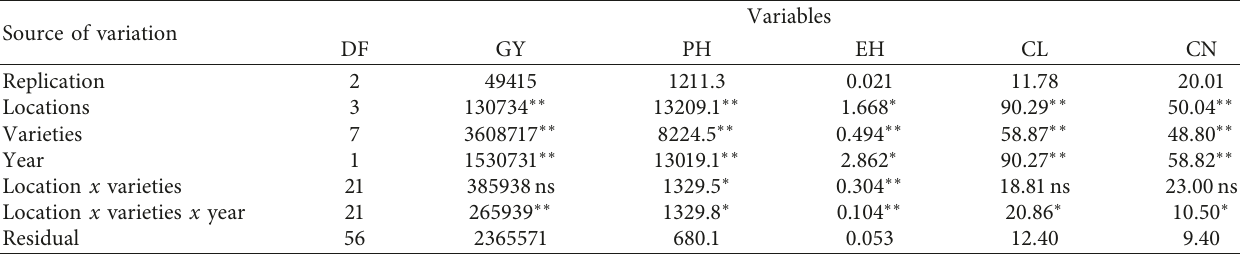
Table 2: Analysis of variance for agronomic traits of maize varieties across locations during 2017 and 2018 in Basketo special and Melokoza districts, Southern Ethiopia.